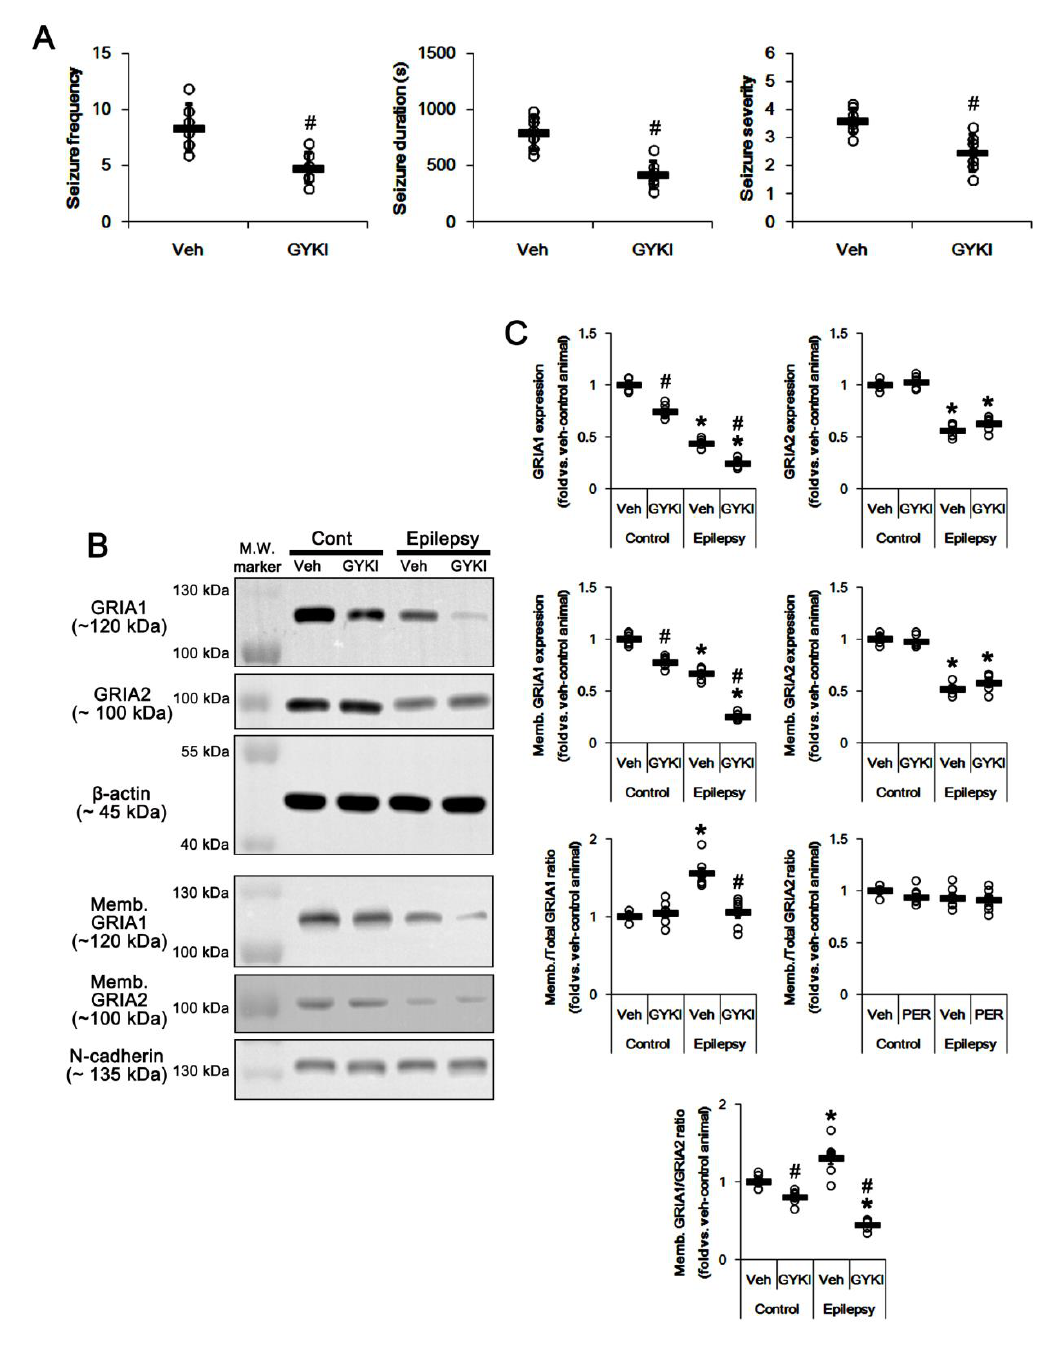
Figure 2. The effect of GYKI 52,466 (GYKI) on spontaneous seizure activity, total GRIA1, and membrane GRIA1 expression in control (cont) and epileptic rats. ( A ) Quantitative values of seizure frequency, total seizure duration, and seizure severity during 2 h of recording a day. Open circles indicate each individual value. Horizontal bars indicate mean value. Error bars indicate SD ( * p < 0.05 vs. vehicle (Veh)-treated animals; Mann–Whitney U-test for seizure frequency and seizure severity; Student’s t -test for seizure duration; n = 7, respectively). ( B ) Representative images for Western blot of GRIA1, GRIA2, membrane GRIA1, and membrane GRIA2 levels in the hippocampal tissues. ( C ) Quantifications of GRIA1, GRIA2, membrane GRIA1, and membrane GRIA2 levels in the hippocampal tissues. Open circles indicate each individual value. Horizontal bars indicate mean value. Error bars indicate SEM ( * , # p < 0.05 vs. vehicle (Veh)-treated control animal and vehicle- treated animals, respectively; one-way ANOVA with post hoc Bonferroni’s multiple comparison; n = 7, respectively).